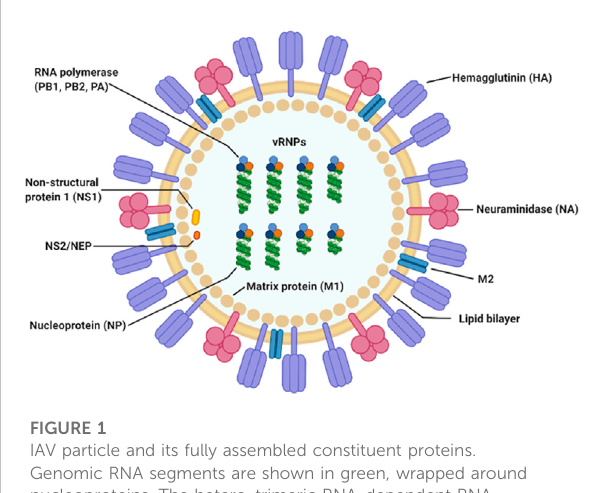
IAV particle and its fully assembled constituent proteins. Genomic RNA segments are shown in green, wrapped around nucleoproteins. The hetero-trimeric RNA-dependent RNA polymerase complex comprising of PB1, PB2, and PA is shown in orange, lightanddarkbluecircles. This fi gure isbyJungand Lee(Jung and Lee,